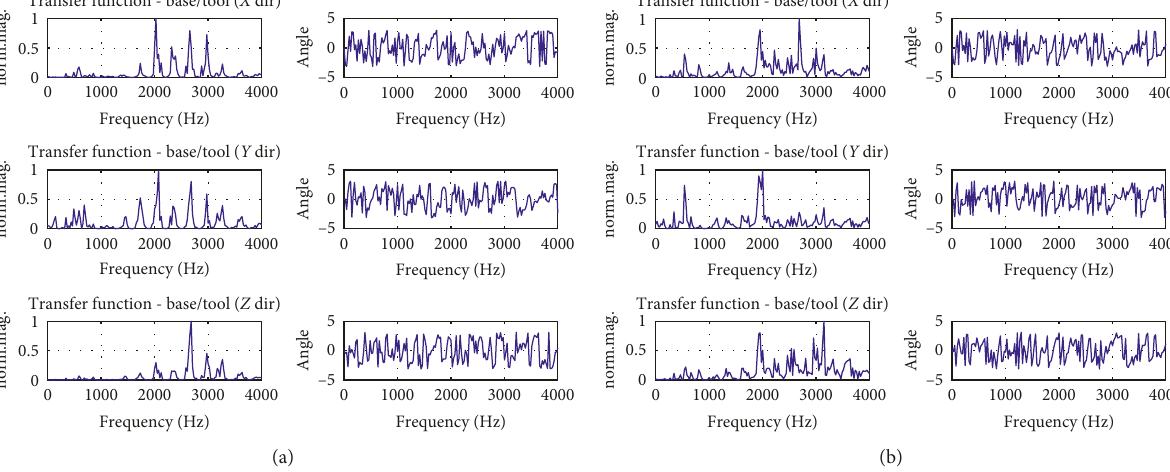
Figure 4: Transfer functions between the bed frame and milling head (normalized magnitudes on left side column and angles in radians on the right side column) for the case of squared shape (a) and circular shape